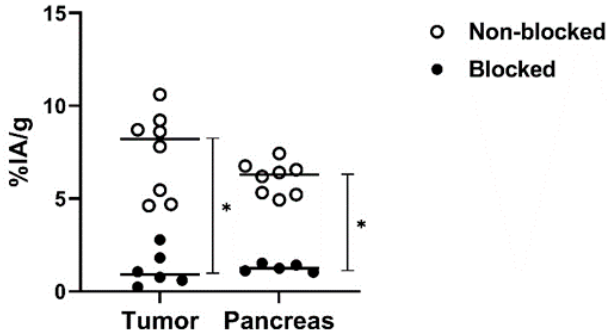
Figure 7. The dot plot representing the in vivo GRPR targeting specificity for [ 99m Tc]Tc-maSSS-PEG 2 -RM26 on BALB/C nu/nu mice bearing PC-3 xenografts at 30 min pi. Each white dot denotes the %IA/g of tissue uptake in a mouse injected with [ 99m Tc]Tc-maSSS-PEG 2 -RM26 alone. Each black dot denotes the %IA/g of tissue uptake in a mouse injected with [ 99m Tc]Tc-maSSS-PEG 2 -RM26 along with 5 nmol of maSSS-PEG 2 -RM26. * indicates a significant difference with a p -value < 0.05.